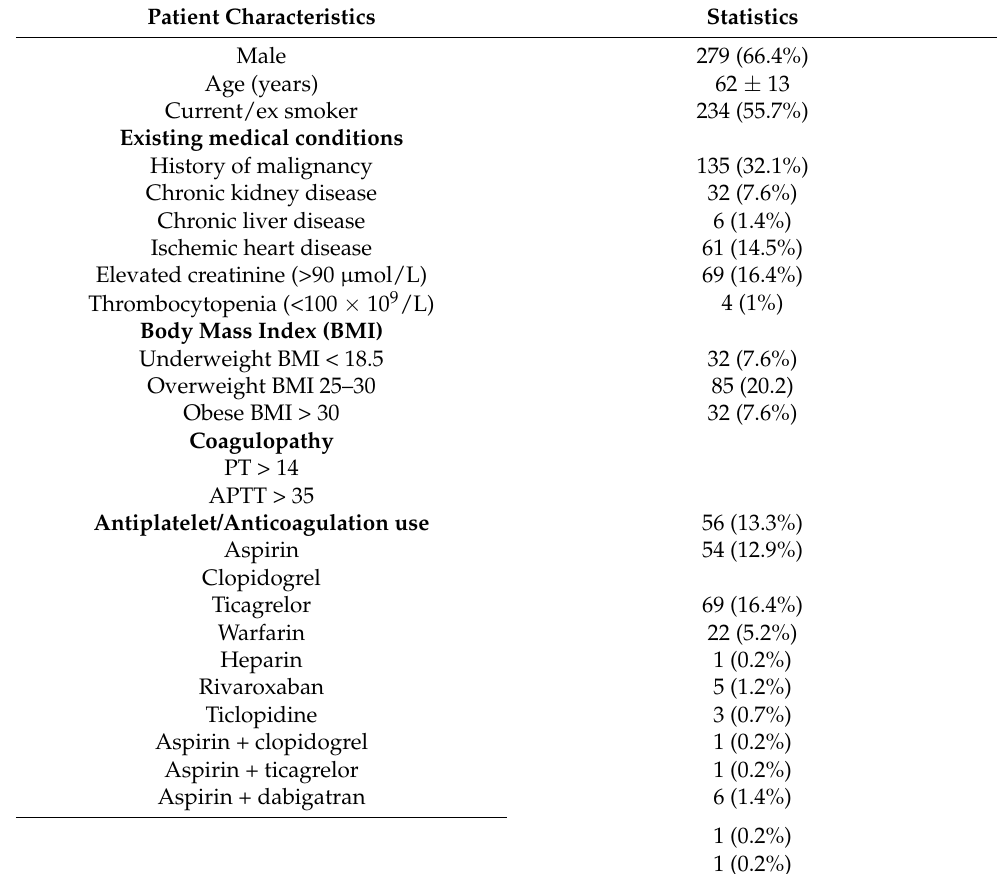
Table 1. Patient characteristics (n =